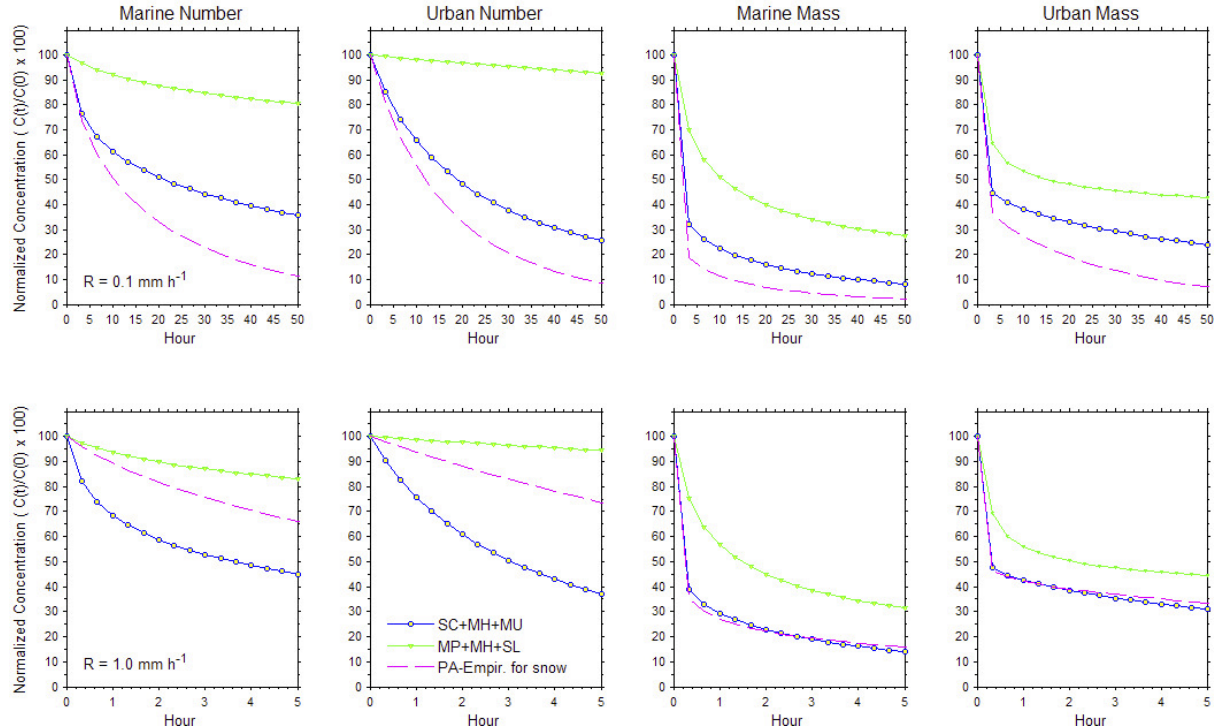
Fig. 9. Time evolution of normalized bulk aerosol number and mass concentrations for typical marine and urban aerosol populations under snow intensities of 0.1 and 1.0mmh − 1 (liquid water equivalent) calculated using two theoretical parameterizations and one empirical 3 snow parameterization shown in Figs. 7 and 8.